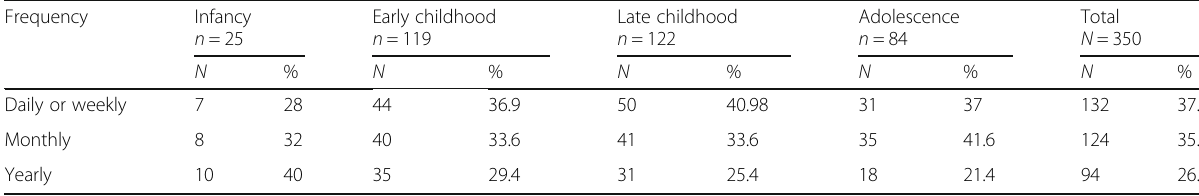
Table 6 Frequency of epileptic seizures among studied epileptic groups